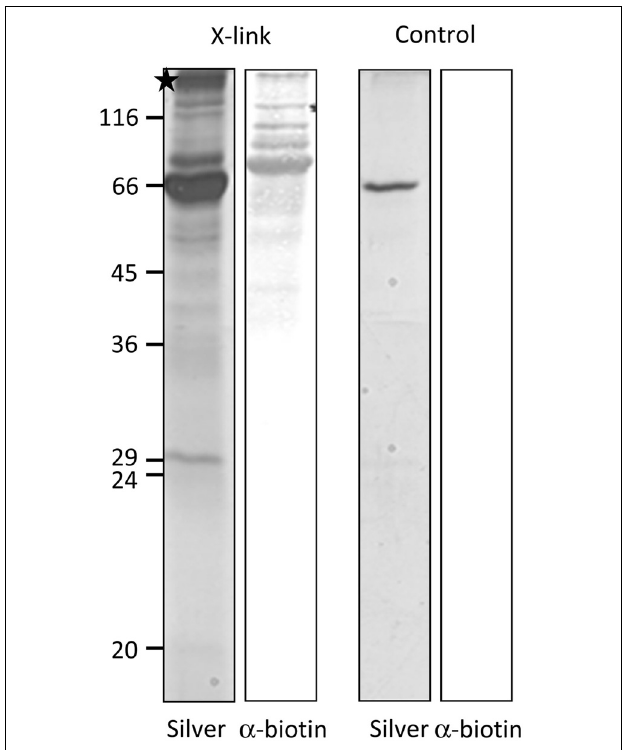
FIGURE 5 | FSD1 N-terminus interacts with large outer envelope proteins. A synthetic peptide representing the first 25 AA of FSD1 including a biotin moiety was incubated with outer envelope vesicles, chemically cross-linked and subjected to SDS-PAGE. The samples were analyzed by silver staining and western blot. A band not present in the control was analyzed by mass spectroscopy (indicated by an asterisk).